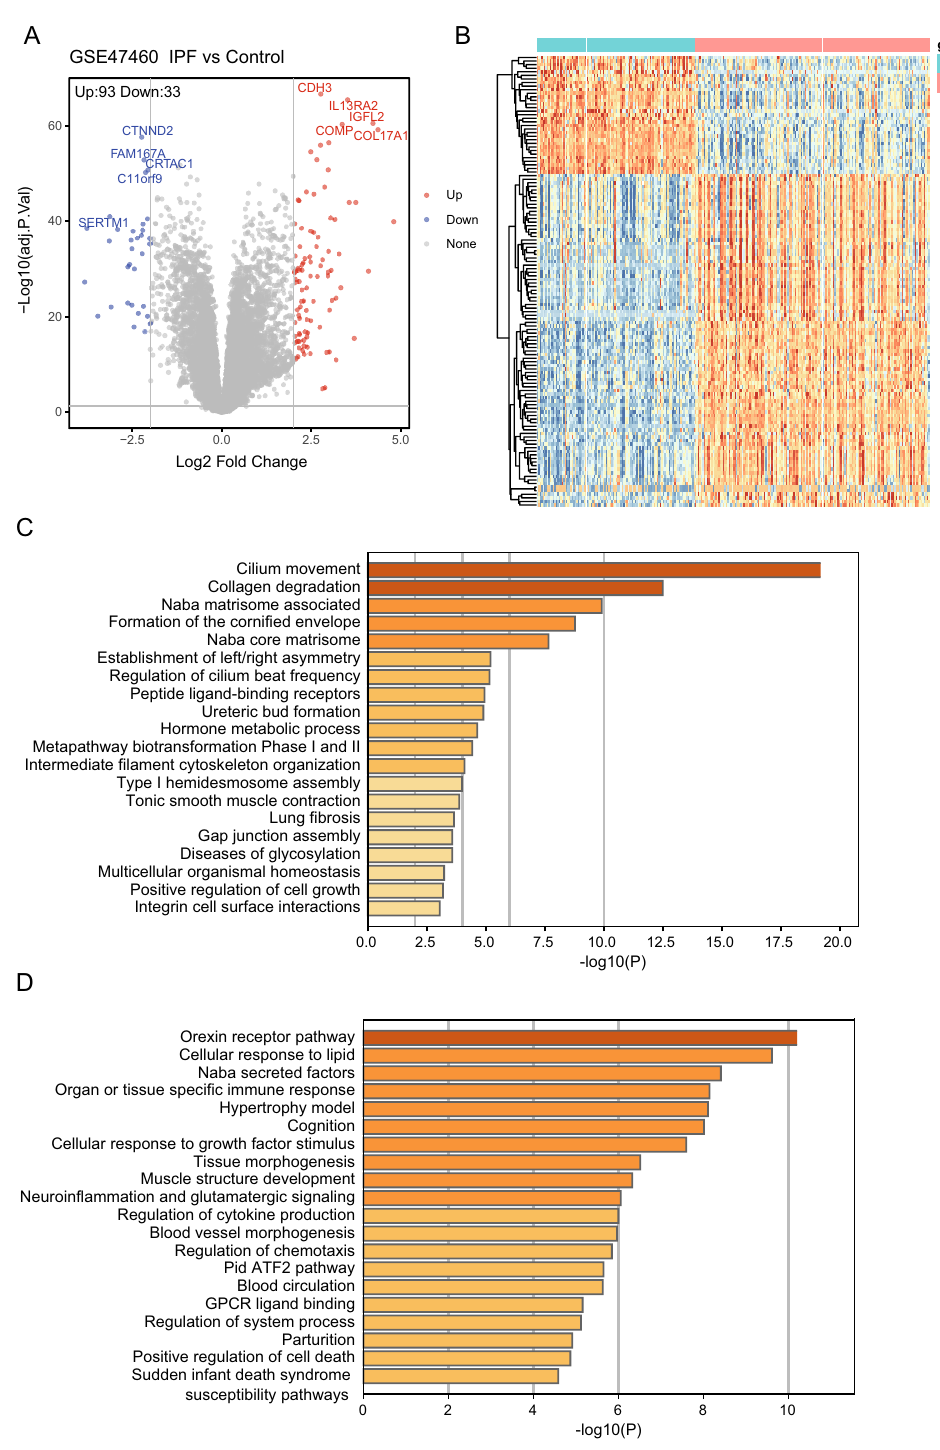
Figure 2. Differential gene expression analysis in IPF. ( A ) Volcano plot of differential expression analysis results. The abscissa is log2Fold Change and the ordinate is –log10 (adj. P value). The upper right part has a adj. P value less than 0.05 and a fold change greater than 2, indicating significant DEGs with higher expression levels. The upper left part has a adj. P value less than 0.05 and a fold change less than − 2, indicating significant DEGs with reduced expression. The gray dots represent the remaining stable genes. ( B ) Heatmap of DEGs. The colors in the graph from red to blue indicate high to low expression. On the upper part of the heatmap, the red band indicates the disease samples and the blue band indicates the normal samples. C-D. Matescape toll function enrichment results bar graph. The x-axis represents −log10(adj P ) values and the y-axis represents enriched pathways. Pathways with Log10( P value) of > 2.5 are marked and shown in the figure. ( C ) shows a bar graph of the enriched pathways that were significantly up-regulated in IPF patients compared to healthy controls. ( D ) shows a bar graph of the enrichment pathway results that were significantly downregulated in IPF patients compared to healthy